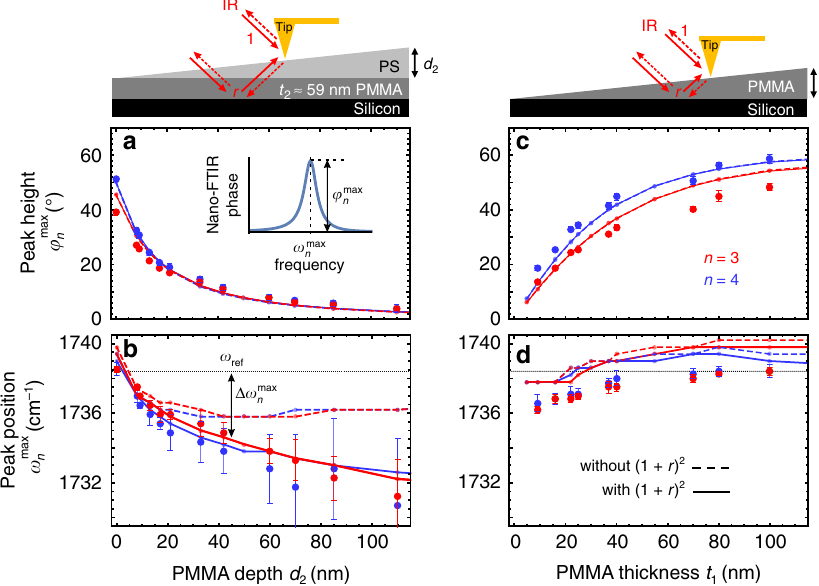
Fig. 3 Comparison of PMMA subsurface layers and thin PMMA surface layers. a , c Peak heights φ max n and b , d spectral peak positions ω max n extracted from experimental (large dots) and calculated (lines) nano-FTIR phase spectra, as a function of PMMA depth d 2 (left column) and PMMA thickness t 1 (right column), for different demodulation orders n = 3 (red) and n = 4 (blue). The solid and dashed lines are calculated with and without the far- fi eld factor (1 + r )² in Eq. (1), respectively. The gray horizontal dotted line indicates the peak position ω ref experimentally obtained on thick (bulk) PMMA samples. Inset: de fi nition of φ max n and ω max n . Each experimental data point shows mean values and standard deviation (error bars) obtained from ten averaged (5×) spectra (16 averaged spectra for d 2 ≥ 85